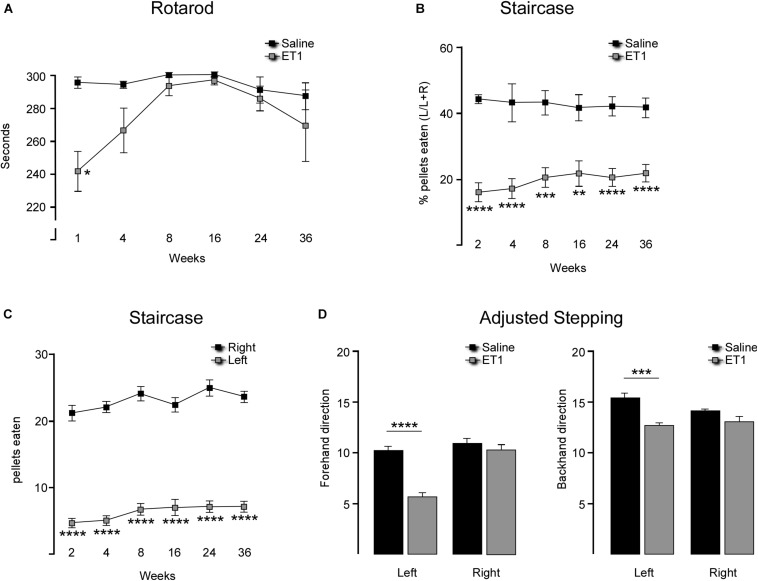
Longitudinal comparison of motor performance in rats injected with saline or ET-1. (A) Mean latency to fall (±SEM) on the accelerating rotarod was significantly shorter for ET-1 treated animals (n = 7) at 1 week but not significantly different from saline controls (n = 6) from 4 weeks and later [two way ANOVA with Sidak’s multiple comparison: Interaction factor F5,63 = 1.817, p = 0.111, Time factor F5,63 = 2.536, p = 0.0373, Group factor F1,63 = 10.42, p = 0.002; t(63) = 3.829; ∗∗p < 0.0018]. (B) Successful pellet retrieval using the forelimb contralateral to the injected hemisphere (left forelimb) was significantly lower for ET-1 treated animals (n = 18) compared to the saline controls (n = 8) at all time-points tests up to 36 weeks (two-way ANOVA with Sidak’s multiple comparison: Interaction factor F5,121 = 0.5086, p = 0.7693, Time factor F5,121 = 0.1052, p = 0.9909, Group factor F1,121 = 129.6; p < 0.0001; ∗∗p = 0.0012, ∗∗∗p < 0.001, ****p < 0.0001). (C) Total pellets retrieved with each forelimb shows a significant reduction in skilled use of the left forelimb in ET-1 animals (n = 18) compared to the saline controls (n = 8) at all time-points tests up to 36 weeks (two-way ANOVA with Sidak’s multiple comparison: Interaction factor F5,194 = 0.3998, p = 0.8485, Time factor F5,194 = 3.171, p = 0.0089, Group factor F1,194 = 911.6, p < 0.0001; ****p < 0.001). (D) At the 36 week time-point, ET-1 treated animals (n = 7) displayed a significant reduction in their capacity to make adjusted, weight-baring steps with the left forelimb compared saline controls (n = 7) in both the backhand and forehand directions (t-test for each forelimb; ∗∗∗p = 0.0002; ****p < 0.0001) while there was no difference in performance for the right forelimb between treatment groups. All data shown as the group mean ± SEM.